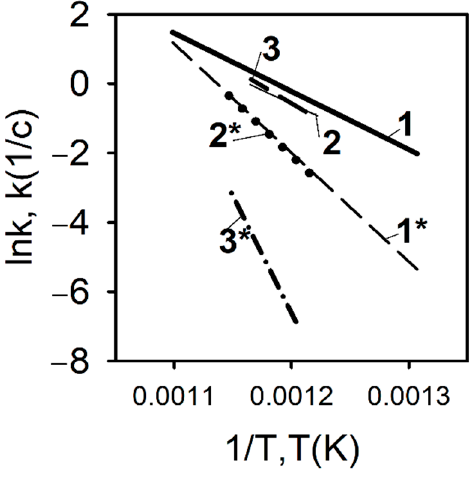
Figure 17. The rate constant of PE and PE/TPP (10%) degradation at a high heating rate (150 K/s). 1—UHMWPE (5 × 10 6 ); 1*—UHMWPE (5 × 10 6 ) + 10%TPP; 2—HDPE (3.8 × 10 5 ); 2*—HDPE (3.8 × 10 5 ) + 10% TPP; 3—HDPE (10 5 ); 3*—HDPE (10 5 ) + 10% TPP.